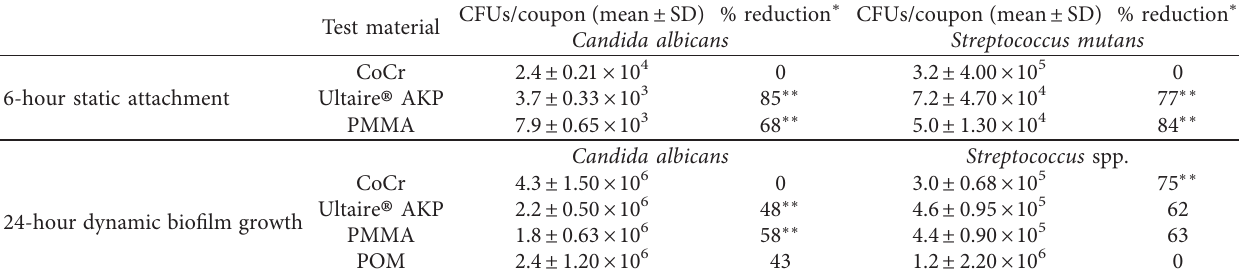
Table 1: Attachment and biofilm growth of Candida albicans and Streptococcus spp. on selected dental materials.